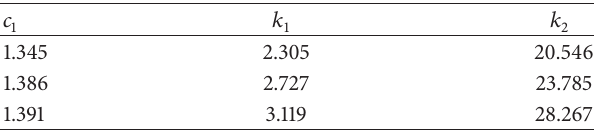
Figure 13: Stress-strain curve of gross area for all prism specimens. Table 2: Parameters of the approximate